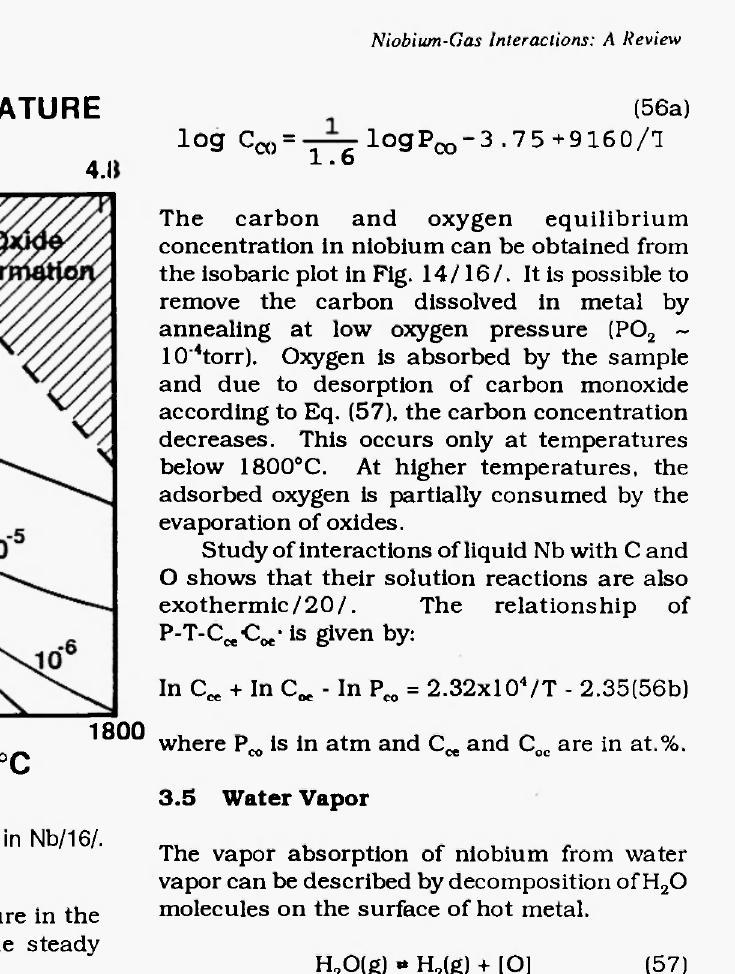
Fig. 11: Evaporation of oxygen in